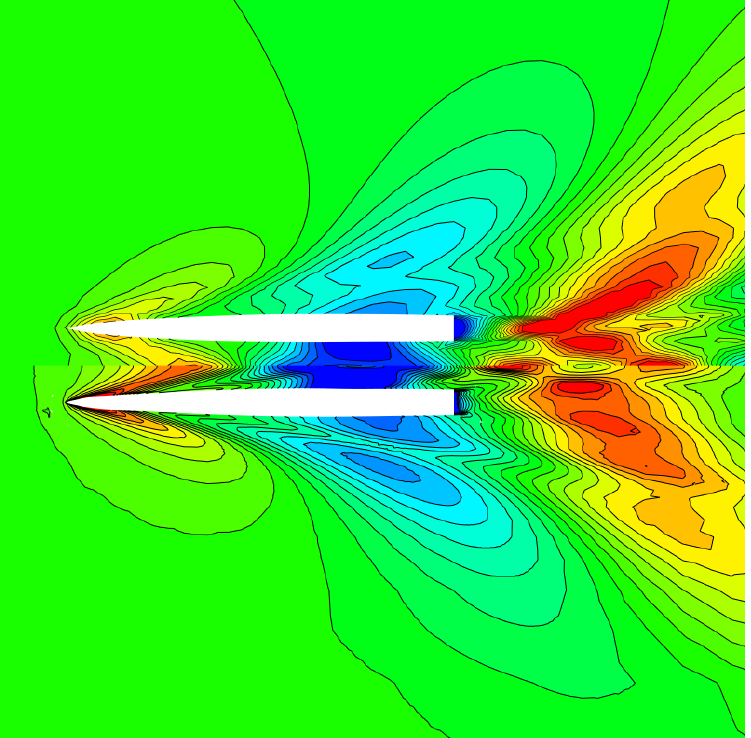
Figure 22. Free surface elevation computed for the design optimised with Neptuno (NEP-OPT) by SHIPFLOW (upper half of the cat’s wave pattern) and Neptuno (lower half of the cat’s wave